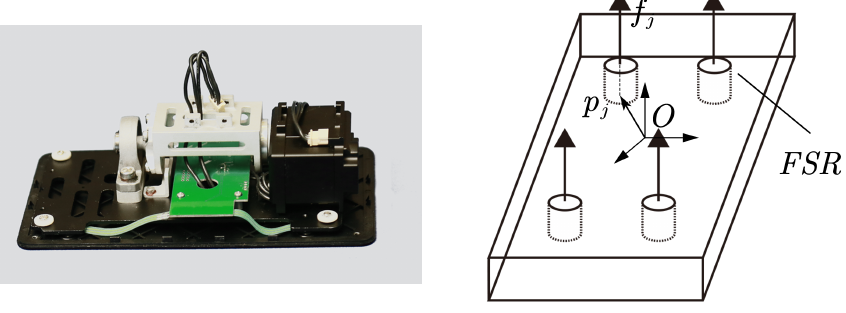
Figure 5. Picture of force sensitive resistor (FSR) sensors and a simplified force measuring schematic